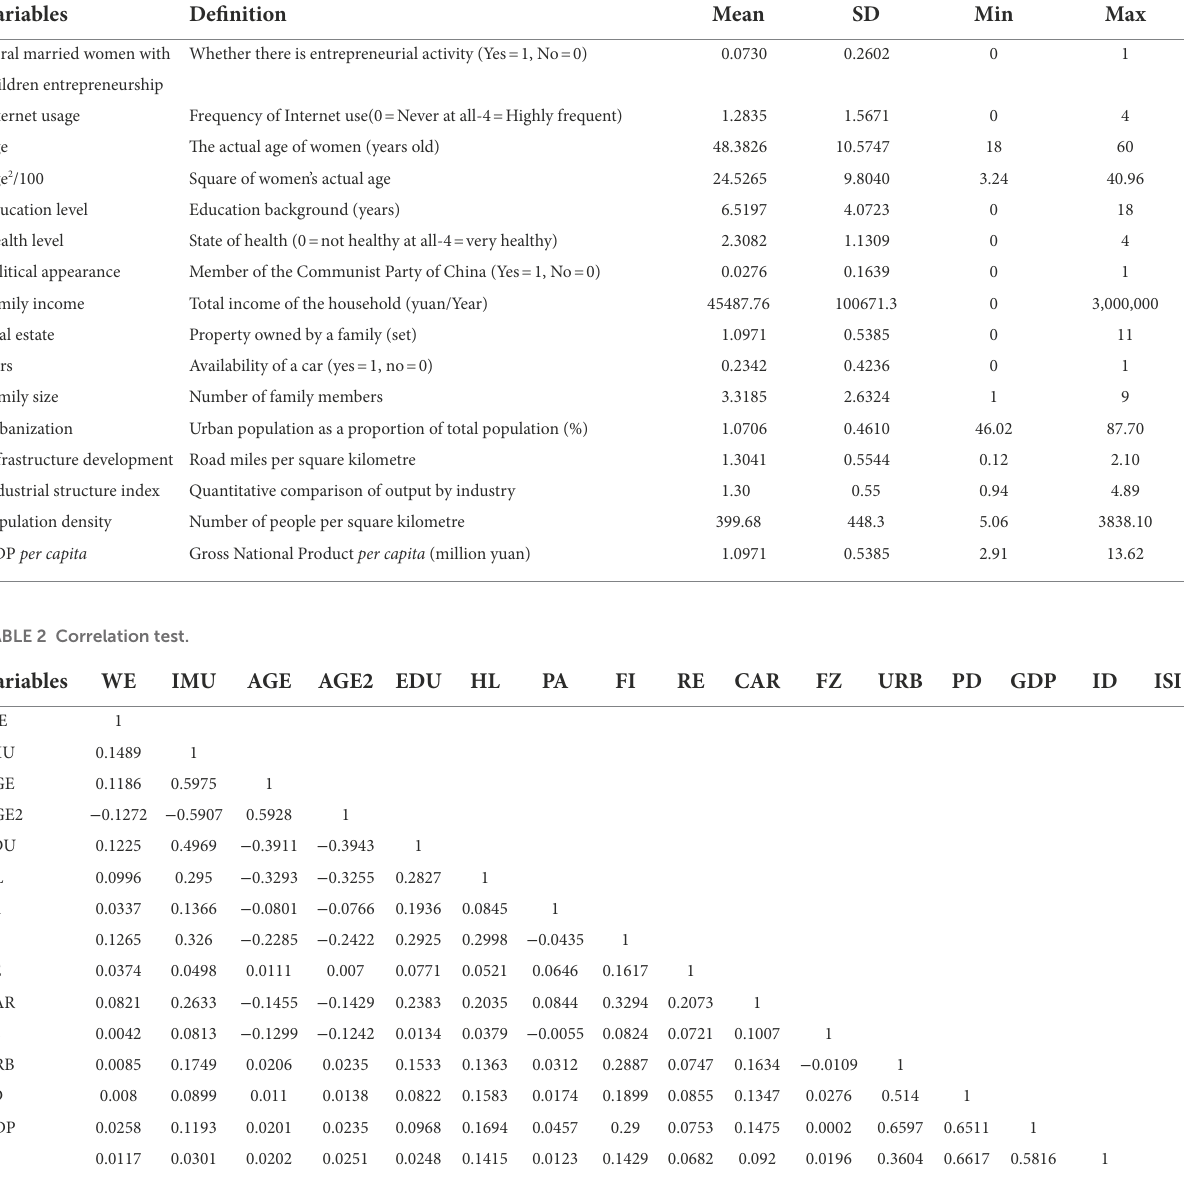
TABLE 1 Summary